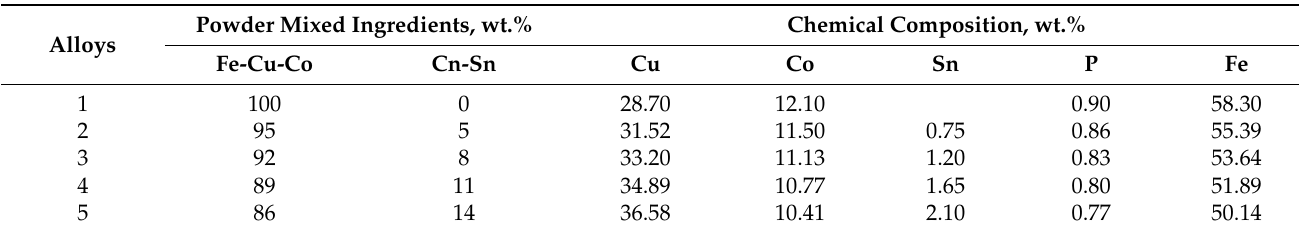
Table 1. Powder mixed ingredients and chemical composition of alloys. Powder Mixed Ingredients, wt.% Chemical Composition, Alloys